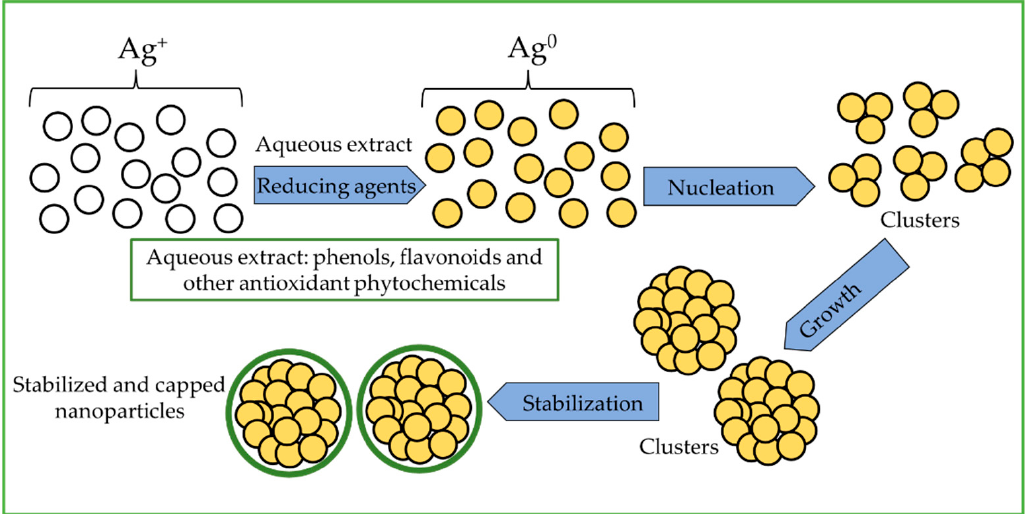
Figure 1. General scheme of the synthesis mechanism of silver nanoparticles using plant extracts. The change to yellow-brown is characteristic and indicates the formation of